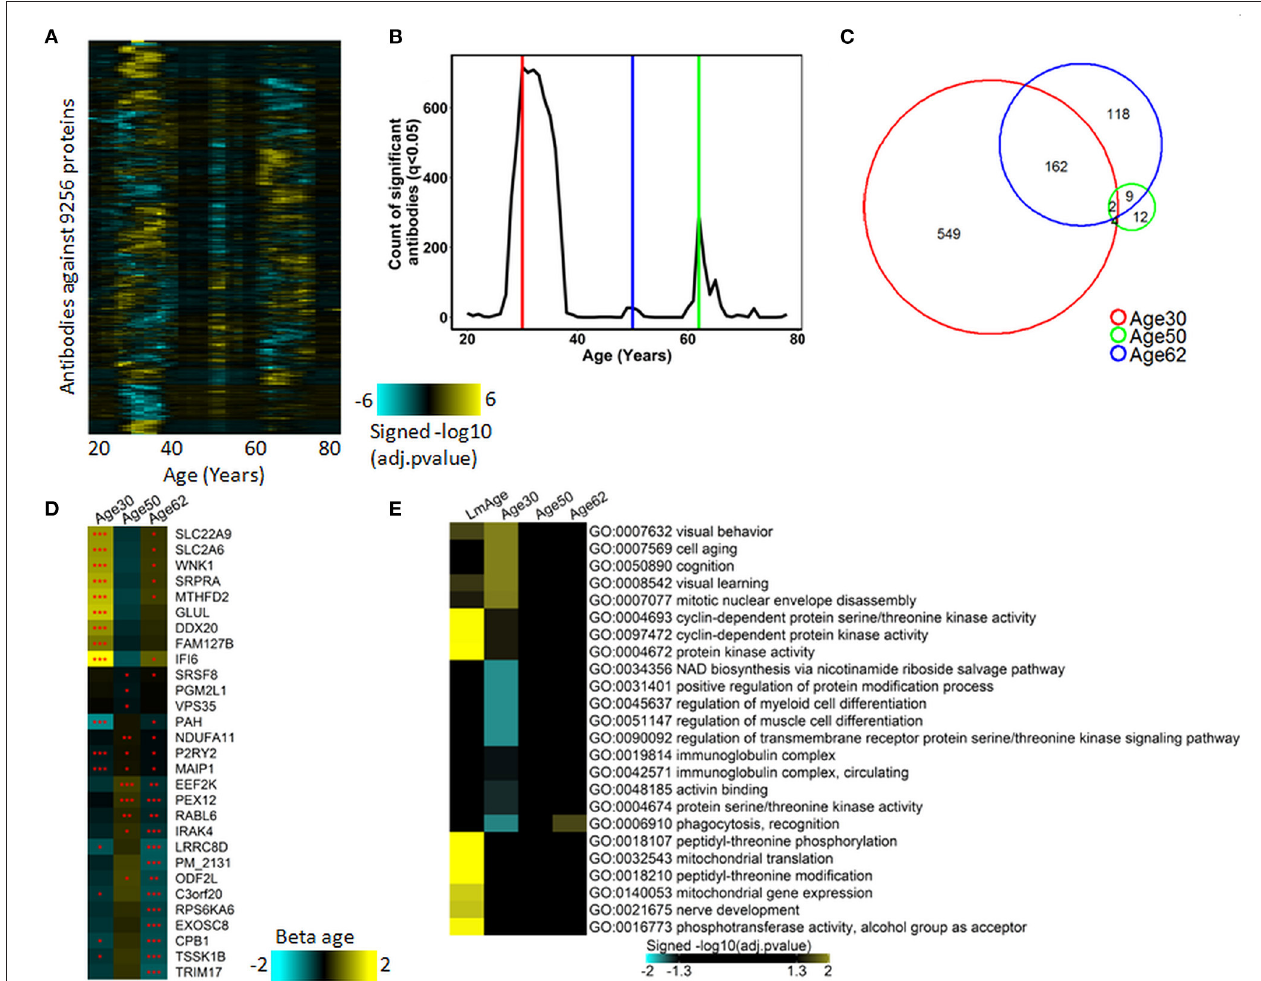
FIGURE 2 | Waves of autoimmunomic changes with age. (A) Changes in autoantibody expression during aging in 155 healthy subjects. Within each window, p -values plotted in a log10 scale were estimated by DE-SWAN with age and sex as covariates and then adjusted using the Benjamini–Hochberg method. (B) Number of autoantibodies differentially expressed ( P adjusted < 0.05) during aging in ESPD patients identified by DE-SWAN. Three waves peaking at the age of 30 (red line), 50 (blue line), and 62 (green line) years, respectively, were identified by using DE-SWAN. (C) Overlaps among aging-associated autoantibodies identified by DE-SWAN at the age of 30, 50, and 62 years ( P adjusted < 0.05). (D) Top 10 significanlty changed autoantibodies identified by DE-SWAN at the age of 30, 50, and 62 years, respectively. Blue and yellow colors represent local increase and decrease, respectively (* P adjusted < 0.05, ** P adjusted < 0.01, and *** P adjusted < 0.001). (E) Visualization of pathways significantly enriched for aging-associated autoantibodies identified by linear modeling (LmAge) and DE-SWAN at the age of 30, 50, and 62 years. p -values were calculated by DAVID server using Fisher’s test and adjusted using the Benjamini–Hochberg method. Autoantibodies upregulated and downregulated were analyzed separately. Gene ontology (GO) terms and KEGG pathways are shown, and the top 10 significant pathways per condition are